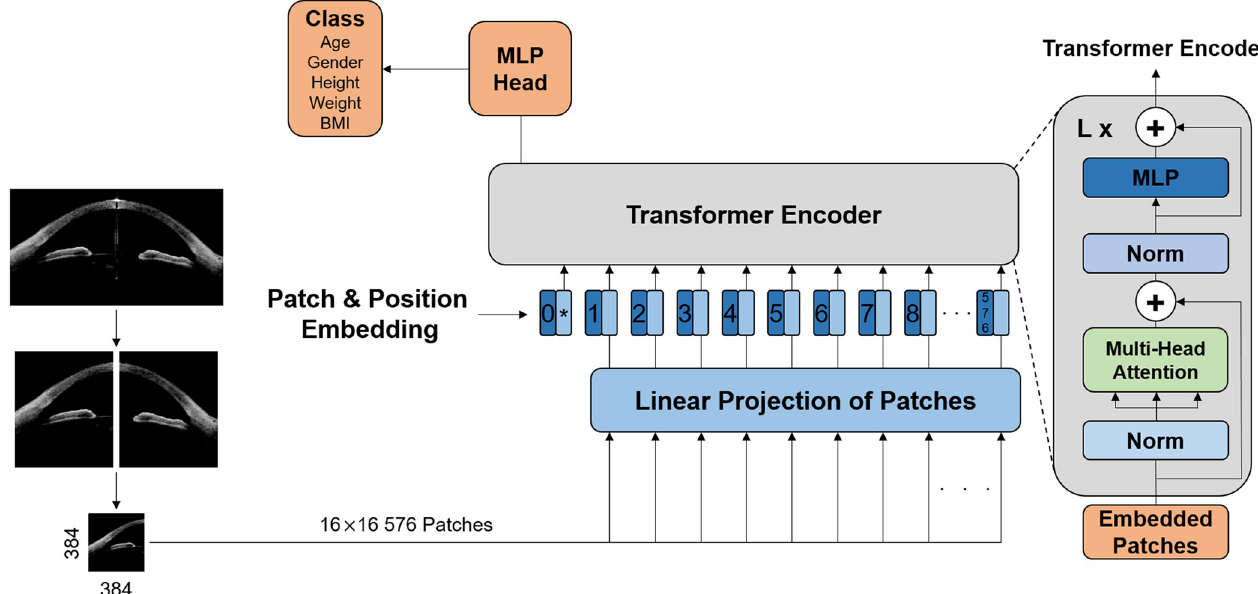
Fig 2. Vision transformer model. Abbreviations: BMI, body mass index; MLP, Multi-layer Perceptron.